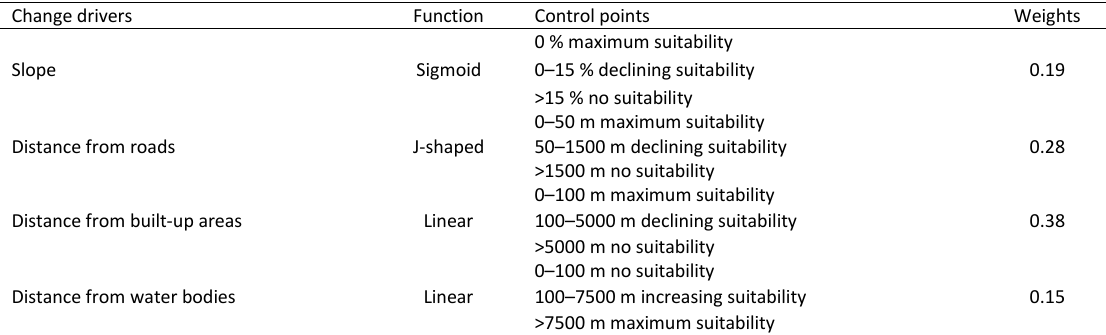
Table 1: Extracted weights based on AHP and fuzzy standardization for urban areas Change drivers